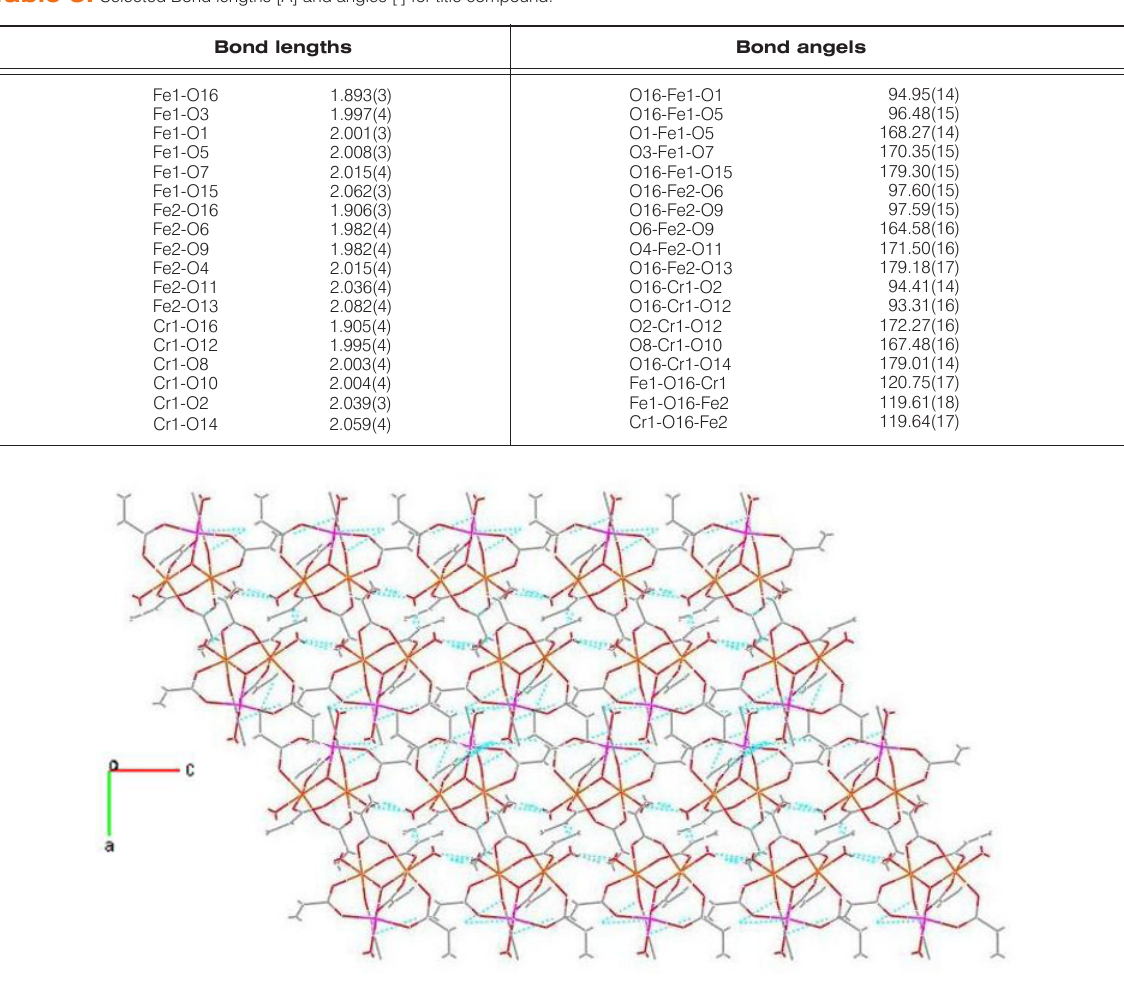
Figure 4. Extended structure of the [Fe